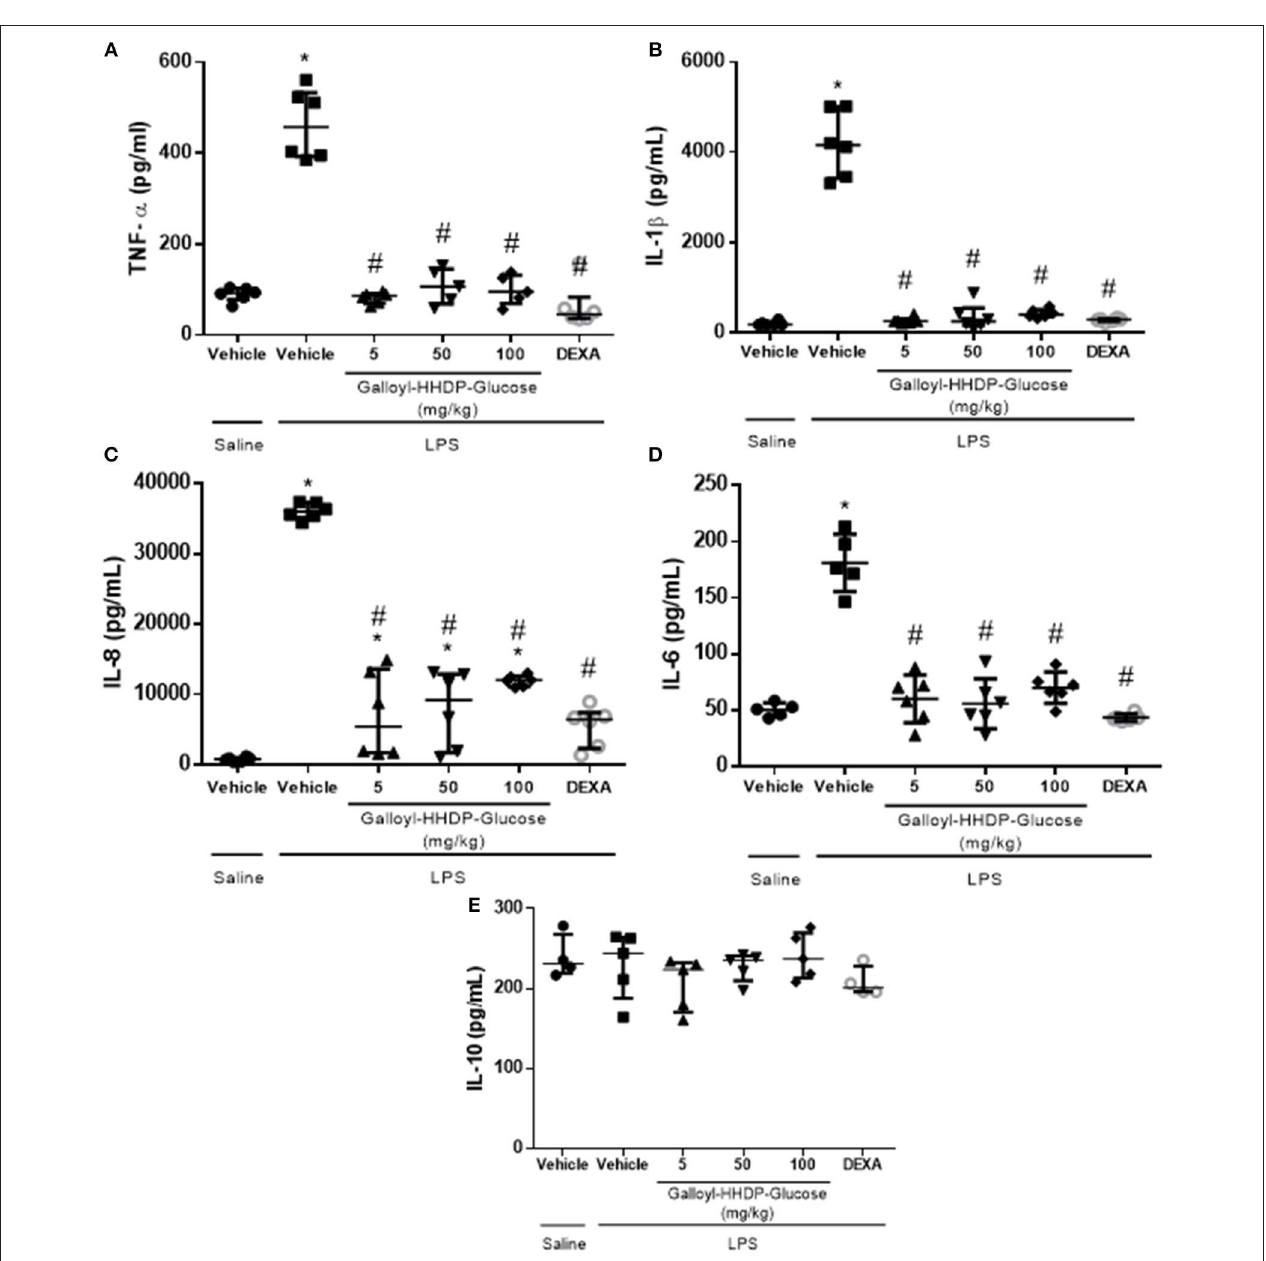
FIGURE 4 | Effects of galloyl-HHDP-glucose treatments on TNF- α (A) , IL-1 β (B) , IL-8 (C) , IL-6 (D) , and IL-10 (E) levels in homogenized isolated lung tissues of BALB/c mice. BALB/c mice were randomly allocated to 6 groups ( n = 6/group). Mice received galloyl-HHDP-glucose (5, 50, and 100 mg/kg; p.o), dexamethasone (DEXA; 5 mg/kg; p.o), or vehicle (PBS; p.o). The values are presented as median and interquartile. Significances were calculated by Kruskal–Wallis followed by Dunn multiple comparison test analysis of the groups vs. saline-injected non-treated mice (* p < 0.05) and vs. lipopolysaccharide (LPS)-installed non-treated mice ( # p <